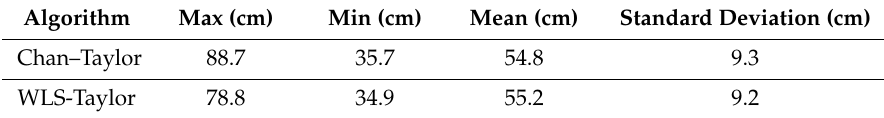
Table 1. Experimental results table of the C-T algorithm and the W-T algorithm.